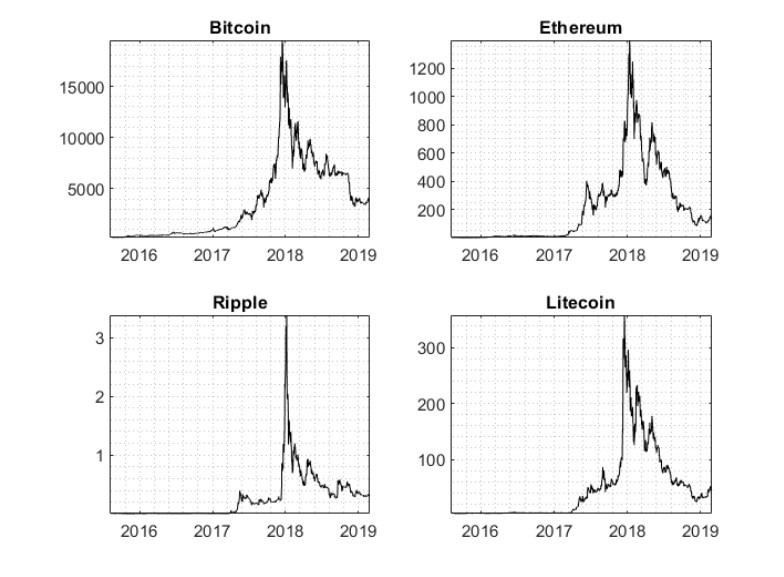
Figure 1. Price of the four cryptocurrencies from 8 August 2015 to 28 February